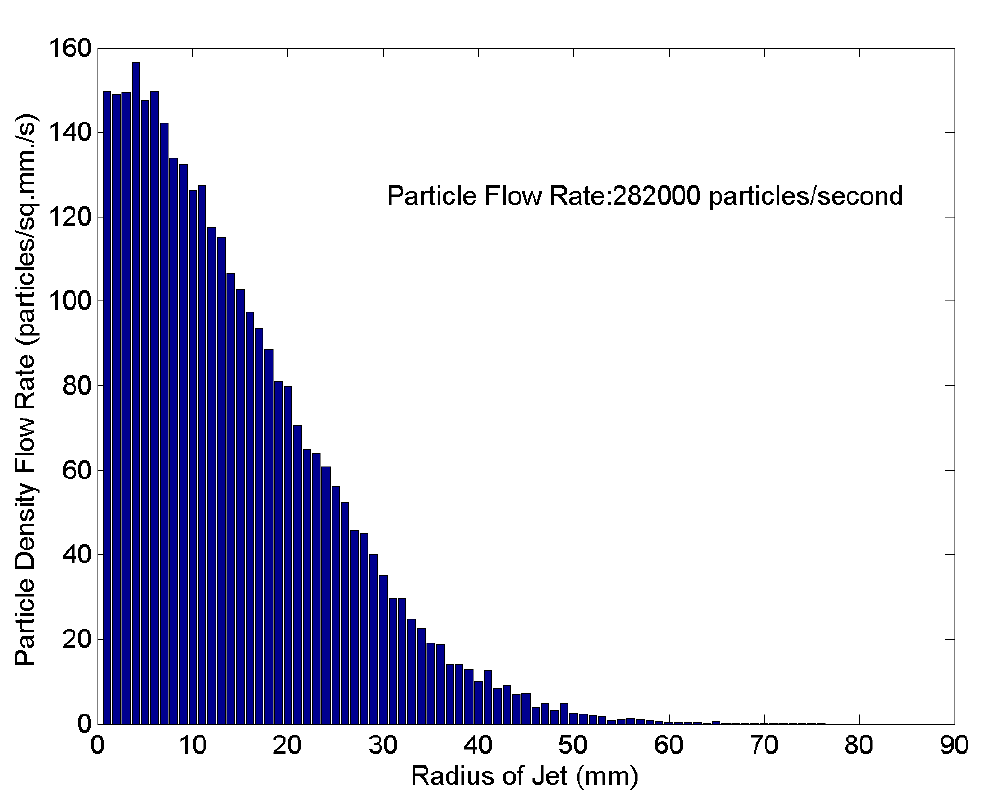
Figure 19. Experiment 2: Radial particle distribution at 40 cm from origin of annular air jet. Exposure time: 2